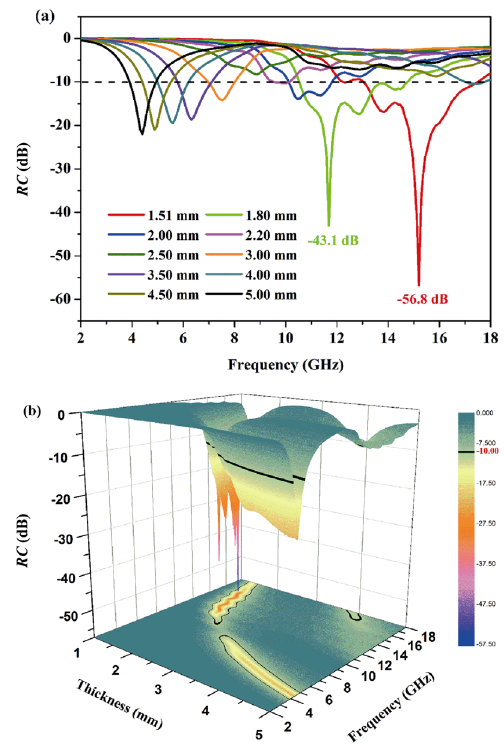
Fig. 10 (a) Calculated theoretical RC values of com- posites of PAD-2 derived carbon-rich SiC mixed with wax versus frequency at different sample thickness variation and (b) corresponding 3D images.